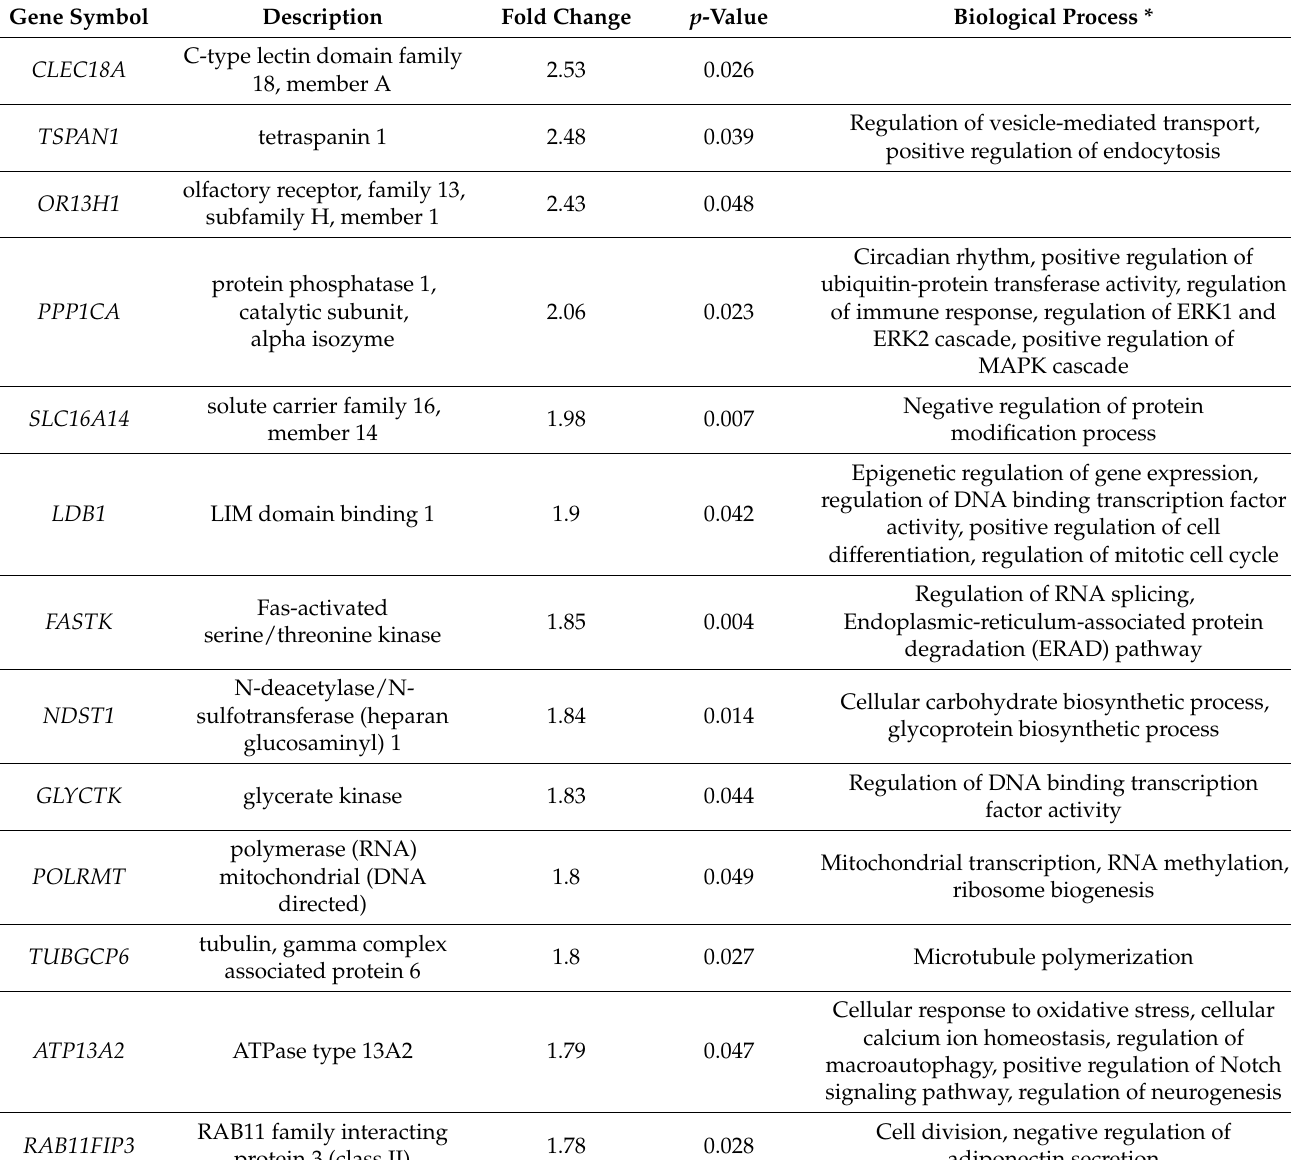
Table 2. Top significantly upregulated DEGs and their biological